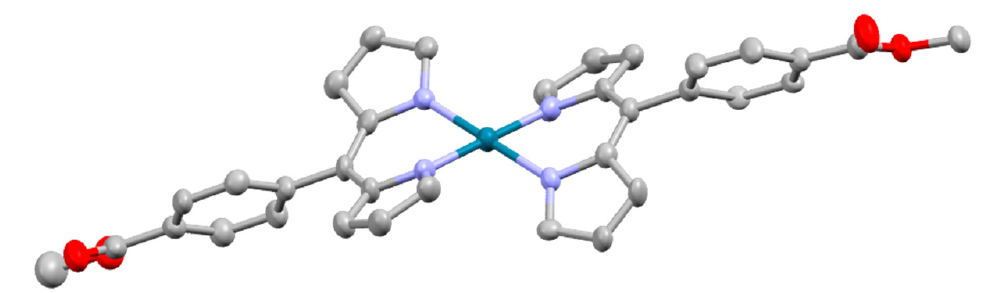
Figure 22. Molecular structure of Pd-6 as determined by X-ray crystallography by Telfer et al. Hydro- gen atoms have been omitted for clarity, thermal ellipsoids show 50% probability [67]. Repulsion between the α -hydrogens causes the complex to be in a ’stepped’ square planar configuration. See the main text for more discussion on the properties of this compound. (CCDC number: 737432 [183]).